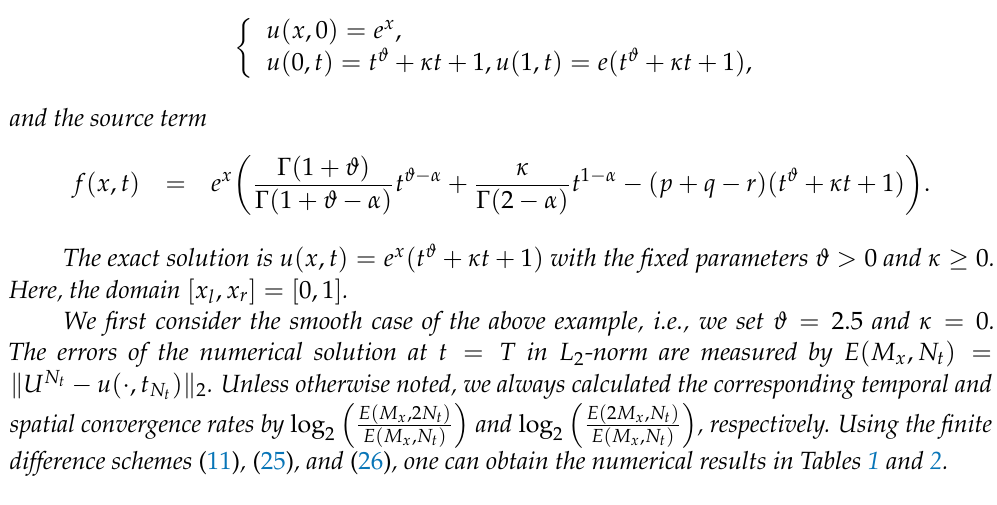
Table 1. The L 2 -norm errors in time for smooth case in Example 1 with h = 1/64 , ϑ = 2.5, κ = 0, r = 0.06, D = 0, and σ =